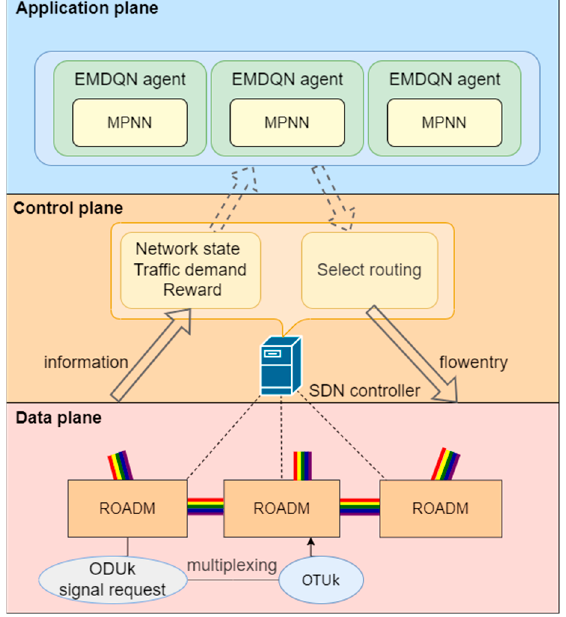
Figure 1. The SD-OTN architecture. The architecture consists of the application plane, control plane, and data plane.